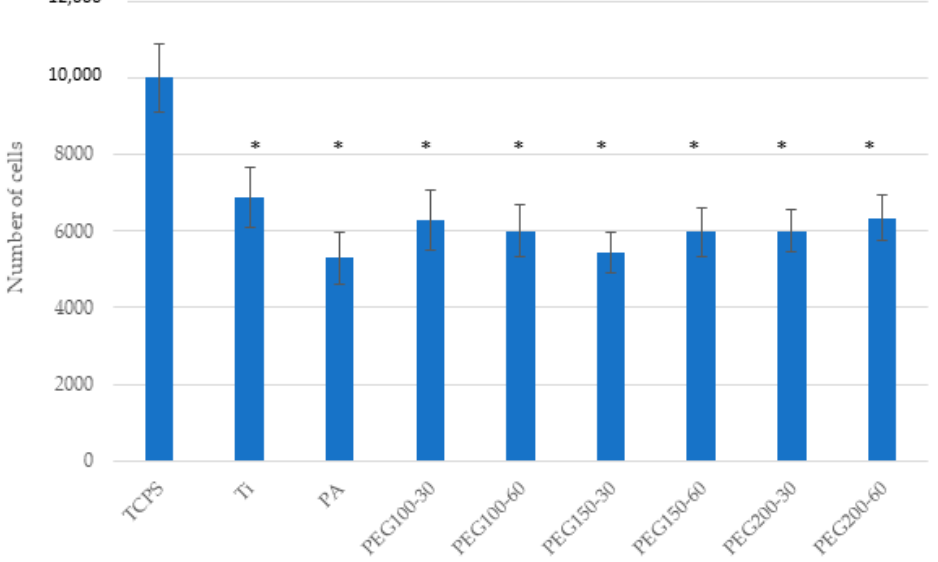
Figure 8. Cell adhesion of hFFs on the Ti, PA and PEG samples. Bars indicated with the same symbol have no statistically significant difference between them ( p < 0.05).